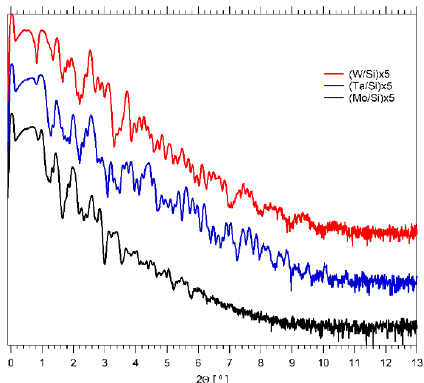
Figure 8. XRR spectra of W/Si, Ta/Si, and Mo/Si periodical multilayer structures consisting of five bilayers and one metal-cap layer. Layer structure and density profile deduced by XRR modeling are given in Figure 9.